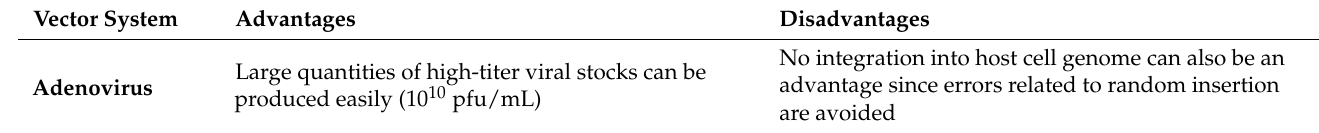
Table 1. Advantages and Disadvantages of Different Expression Systems. Adenovirus [28–30],